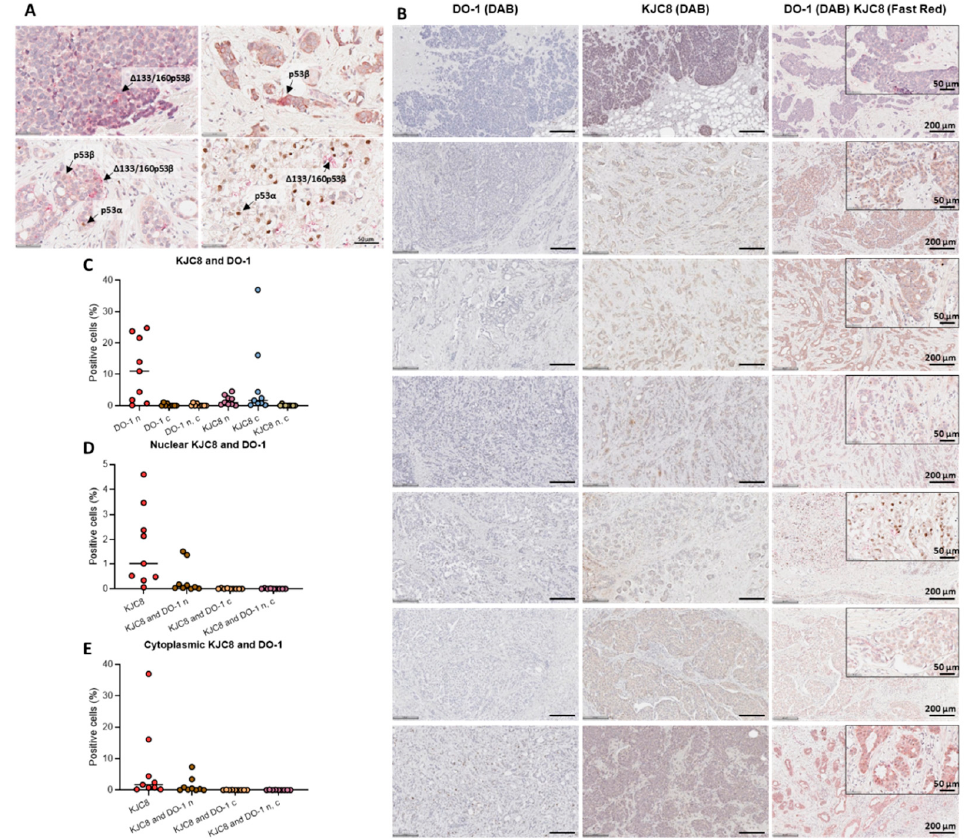
Figure 6. Dual-staining of DO-1 and KJC8 in nine breast cancers (identified as having a recurrence and/or metastasis). ( A ) Representative images of slides stained for TAp53 (DO-1, DAB) and p53 β (KJC8, Fast Red). Scale bar represents 50 µm. ( B ) Representative images of slides stained for TAp53 (DO-1, DAB), p53 β (KJC8, DAB) or both: TAp53 (DO-1, DAB) and p53 β (KJC8, Fast Red). Scale bar represents 200 and 50 µm for 10× and 40× images, respectively. ( C ) Percentage of positive cells for each chromogen found in the cytoplasm, nucleus or both cellular compartments. ( D ) Percentage of positive cells for nuclear KJC8 and/or nuclear DO-1 and/or cytoplasmic DO-1. ( E ) Percentage of positive cells for cytoplasmic KJC8 and/or nuclear DO-1 and/or cytoplasmic DO-1; n: nuclear, c: cytoplasmic. Results are shown as individual values with the median represented by the black line.